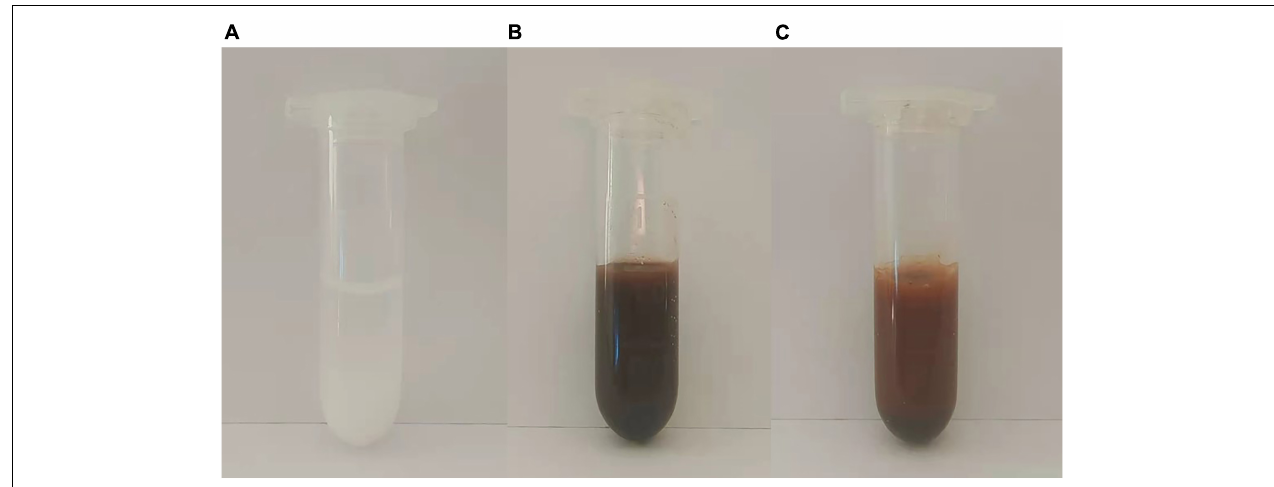
FIGURE 7 | Optimization of the (A) concentration, (C) mass, and (D) contact time, and (B) non-linear fitting of Langmuir and Freundlich models.